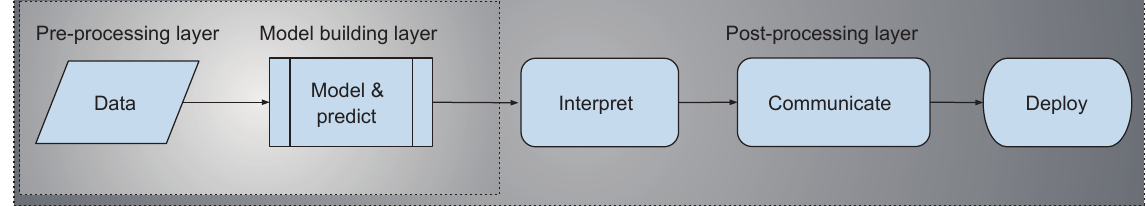
Fig. 2 A reduced model of a DSL. Here, all three layers operate within a black box from the perspective of the constituent/stakeholder, while the post-processing layer operates openly from the perspective of the agents utilizing the